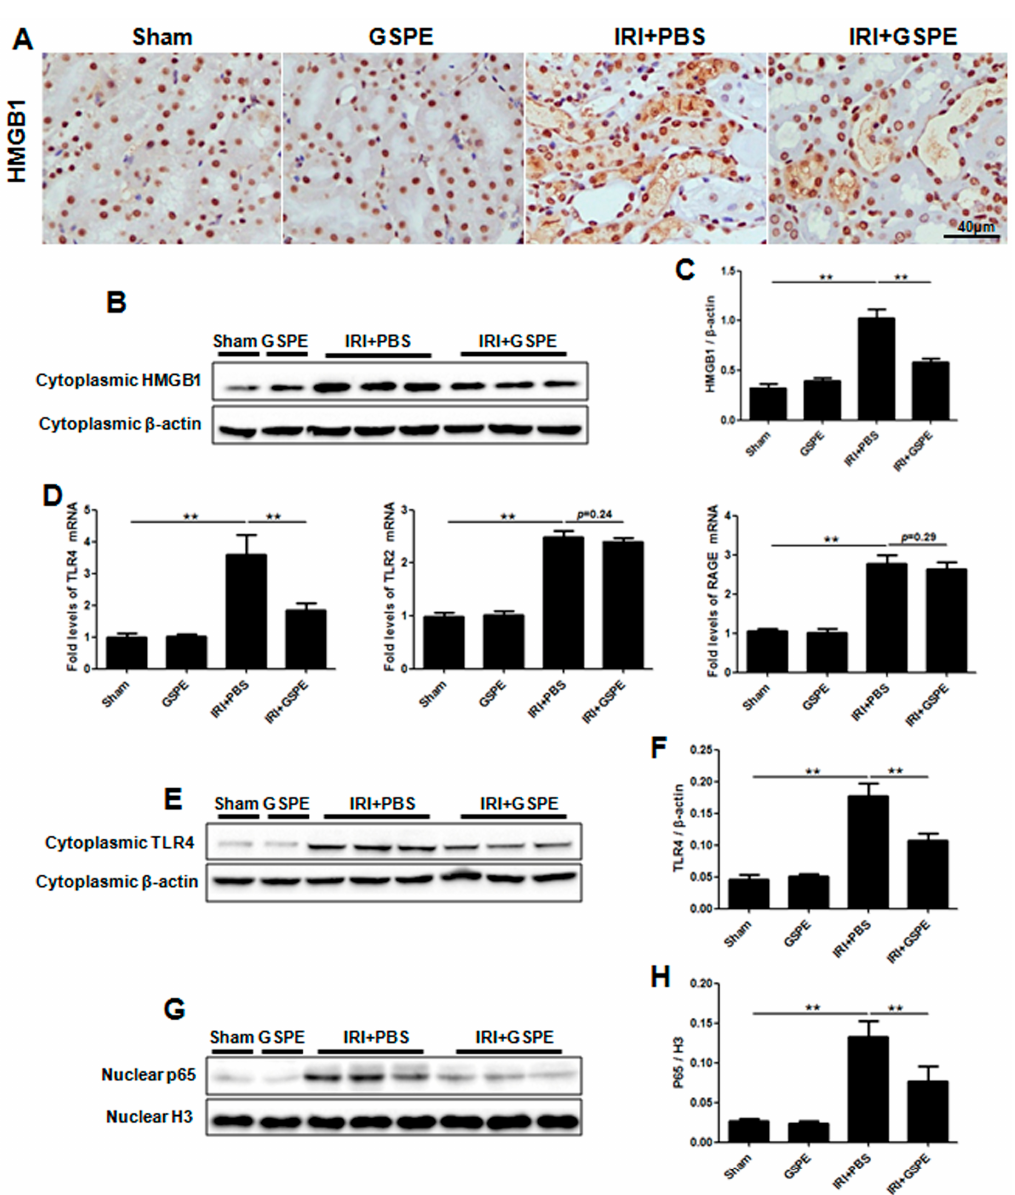
Figure 4. Pretreatment with GSPE suppresses HMGB1-TLR4-p65 activity in AKI. ( A ) Immunohistochemical staining of HMGB1 from sections of kidneys harvested from each of four groups; ( B ) Western blot analysis for HMGB1 was performed using cytoplasmic protein samples; ( C ) The bar graph shows the corresponding densitometry of HMGB1; ( D ) Expression levels of TLR4, TLR2 and RAGE in the kidney were detected by RT-PCR; ( E ) Representative result for Western blot analysis of cytoplasmic TLR4; ( F ) The relative expression of TLR4 is displayed by a histogram; ( G , H ) The expression of nuclear p65 was detected by Western blot, and the histogram shows the relative gray density of P65 corrected for histone 3. The data shown are mean ± SEM (** p < 0.01; n = 7 per group).